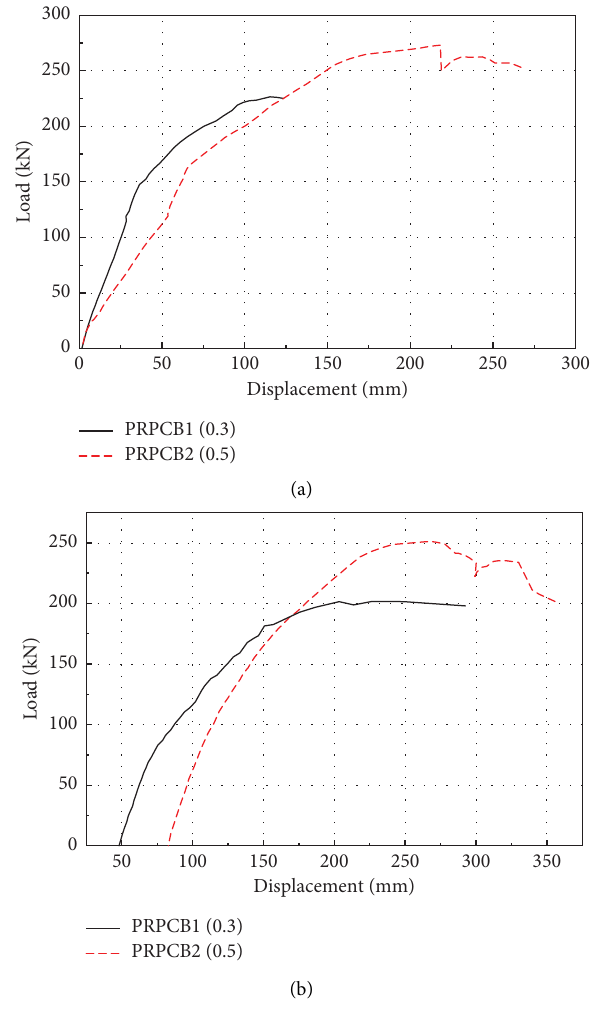
Figure 17: Midspan deformation curve under different load ratios. (a) PRPCB1 and PRPCB2. (b) PRPCB5 and PRPCB6.